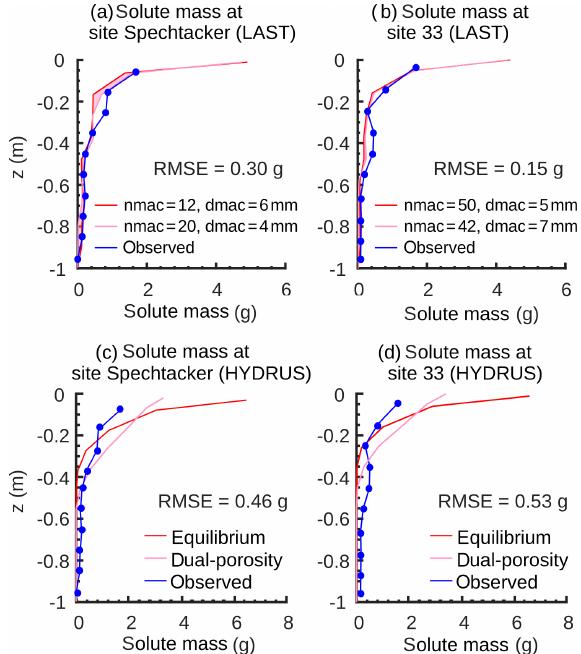
Figure 6. Final simulated and observed vertical bromide mass pro- files of the matrix at the two preferential flow sites Spechtacker and 33 (a, b) with RMSE values simulated with the LAST-Model. The rose area shows the standard deviation of measured macropore numbers and diameters from the mean values at site Spechtacker (cf. Table 1). In comparison, final simulated and observed vertical bromide mass profiles at the two preferential flow sites Spechtacker and 33 (c, d) with RMSE values simulated with HYDRUS 1-D. The rose mass profile is simulated with a dual-porosity approach to ac- count for preferential flow (cf. Sect. 3.3) and, for comparison, the red mass profile is simulated with an equilibrium